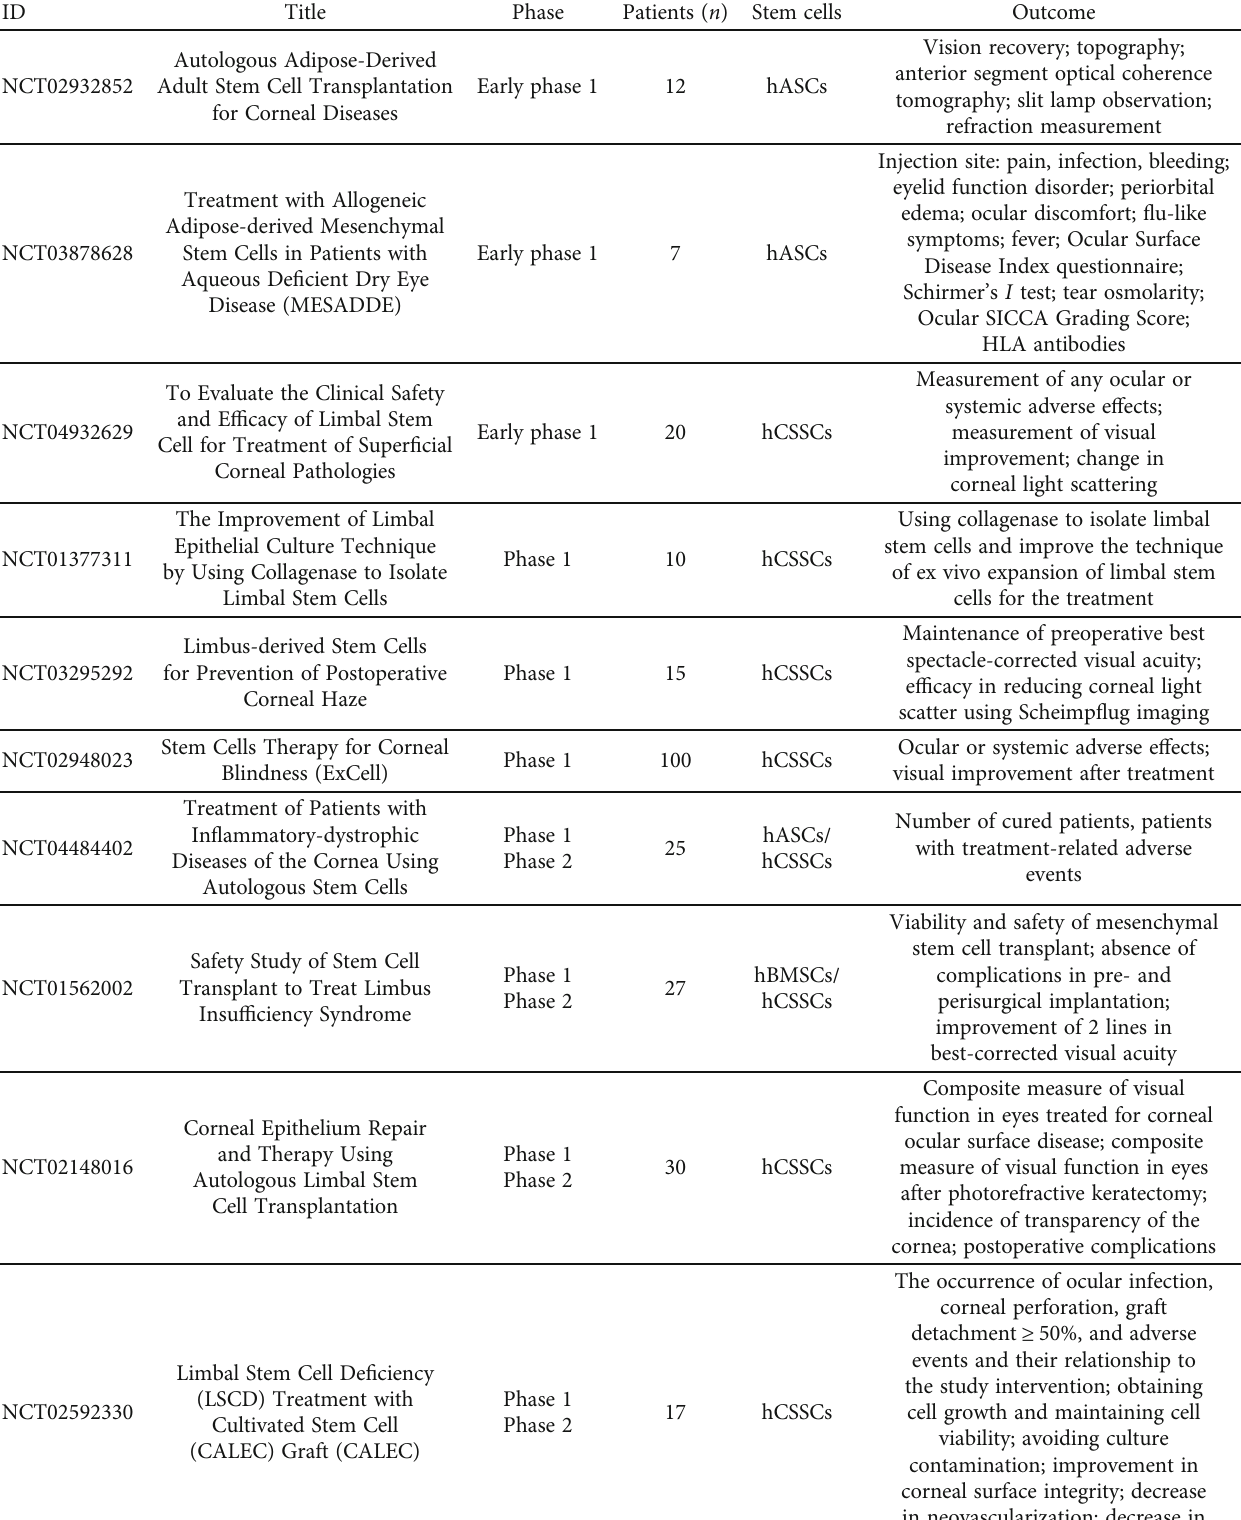
Table 1: Clinical trials of stem cells used for corneal